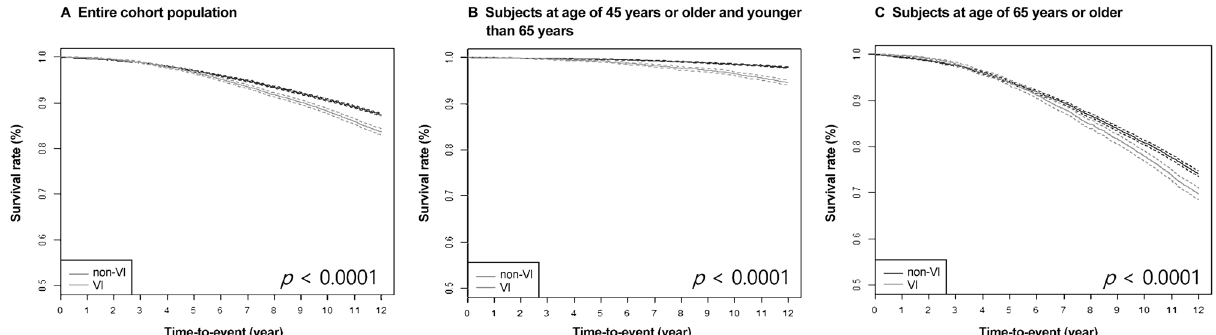
Figure 2. Kaplan–Meier curves for cumulative probability of dementia occurrence according to VI status in ( A ) Entire cohort population, ( B ) Younger age population (< 65 years old), and ( C ) Older age population (≥ 65 years old). Those with VI depicted on the lower line had a higher rate of incident dementia across all age groups by log-rank tests (all p <